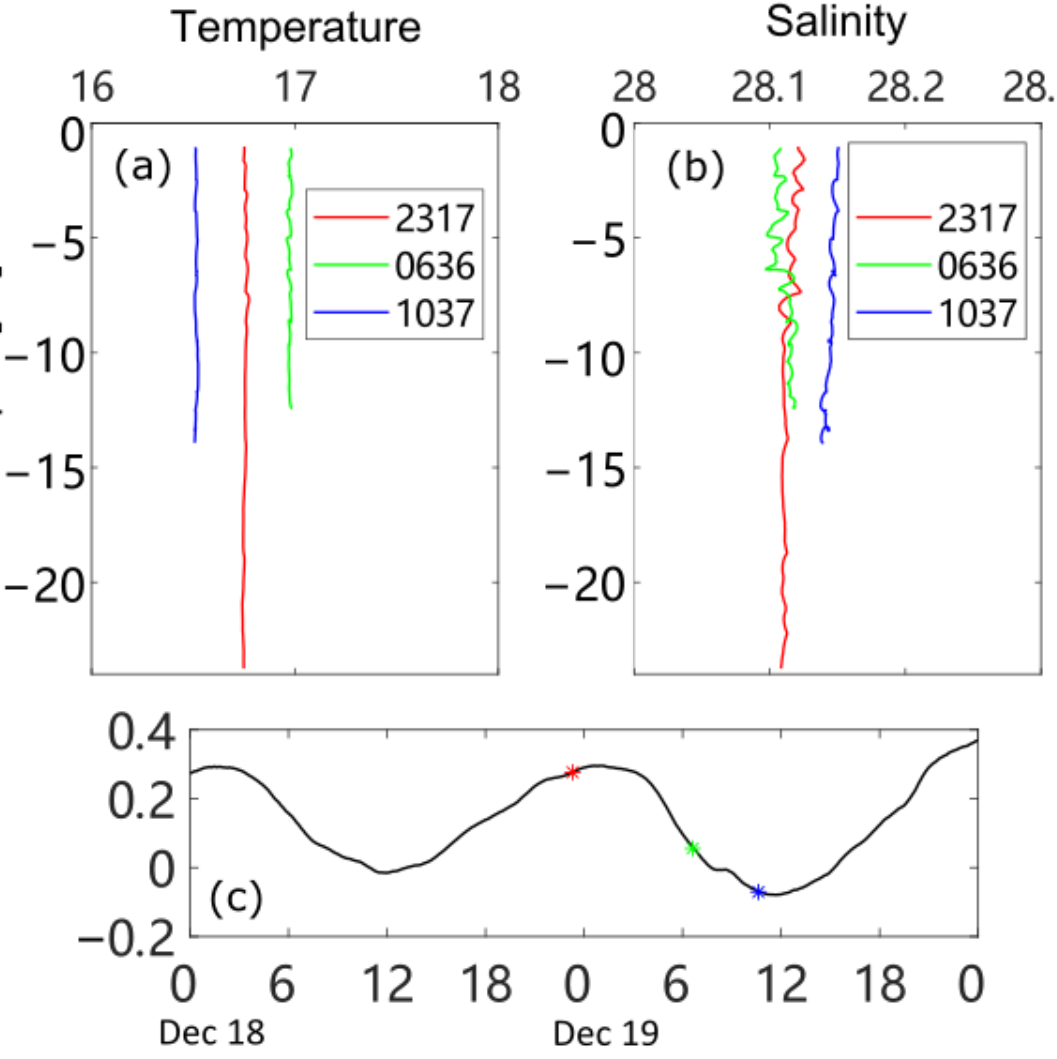
Figure 6. Temperature ( a ) and salinity ( b ) casts during the investigation in December 2014, and water levels labeled with times of corresponding casts ( c ).